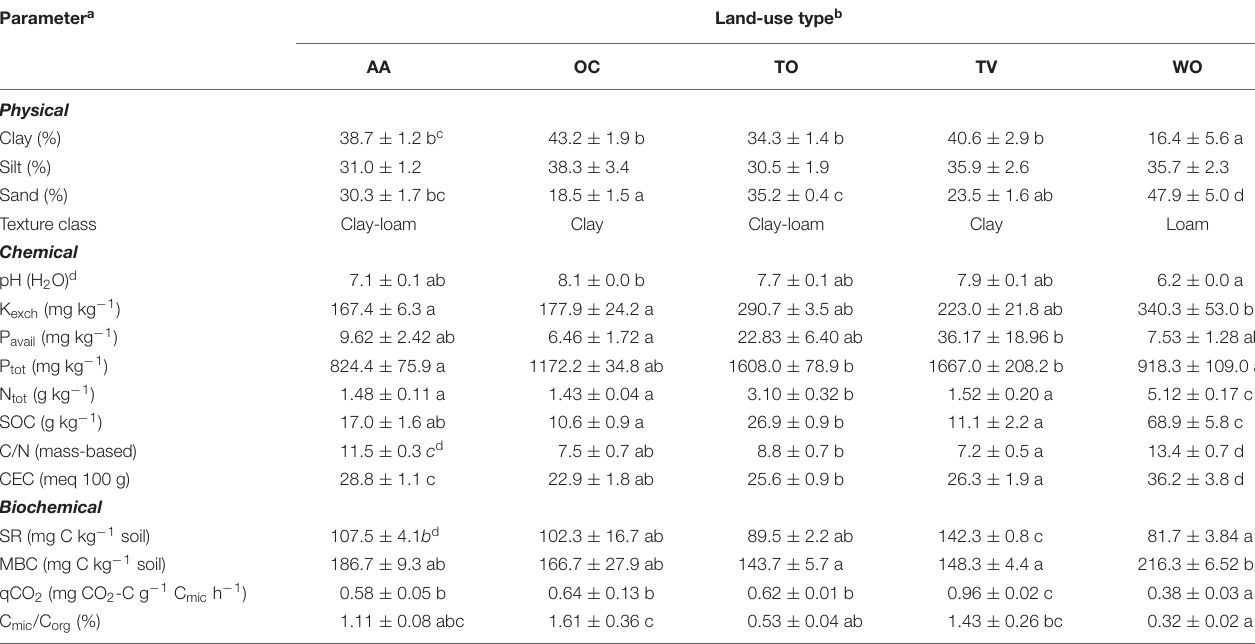
TABLE 1 | Physical, chemical, and microbiological soil properties under five land-use types on three mixed crop-livestock farms in the municipality of Manciano (Tuscany, central Italy). Parameter